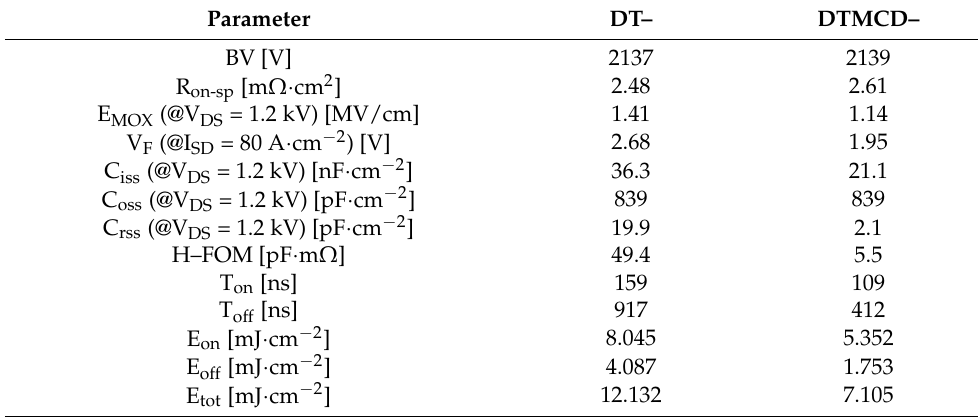
Table 3. Static and dynamic characteristics of